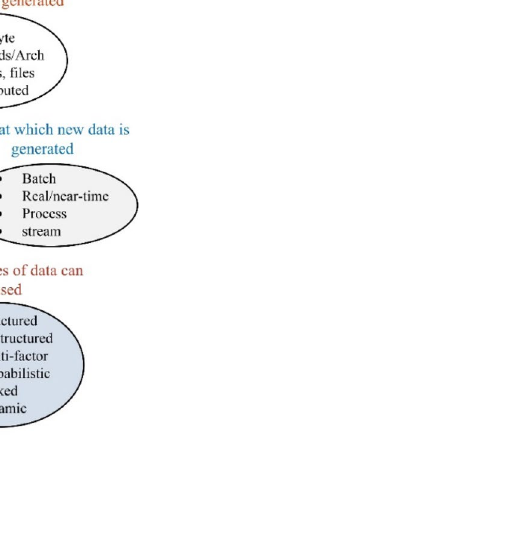
Figure 13. Big Data 5Vs 15